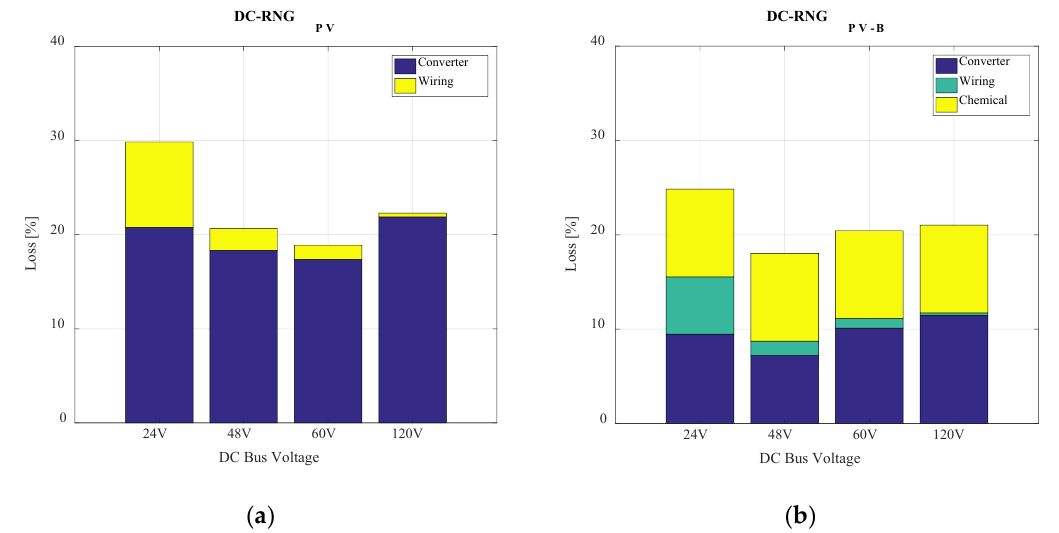
Figure 8. DC-RNG loss breakdown: ( a ) without batteries, ( b ) with batteries.